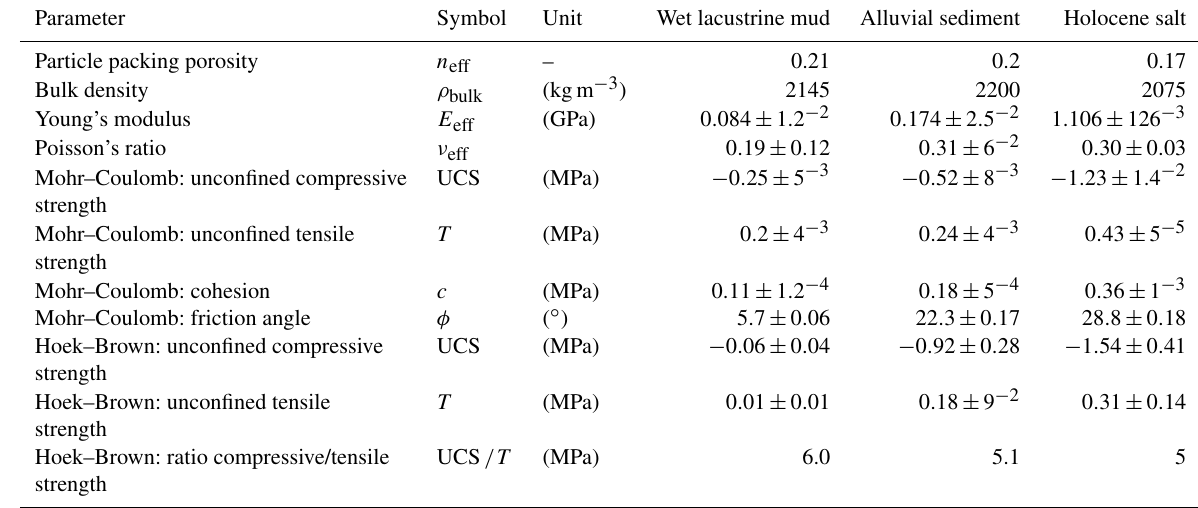
Table 4. Bulk material properties of the three investigated Dead Sea materials as derived by simulated rock tests and measurement circles. All values refer to unconfined conditions (i.e. at or close to the surface). Mohr–Coulomb and Hoek–Brown results are based on compression and tension tests on 10 different particle assemblies for each material. Parameter Symbol Unit Wet lacustrine